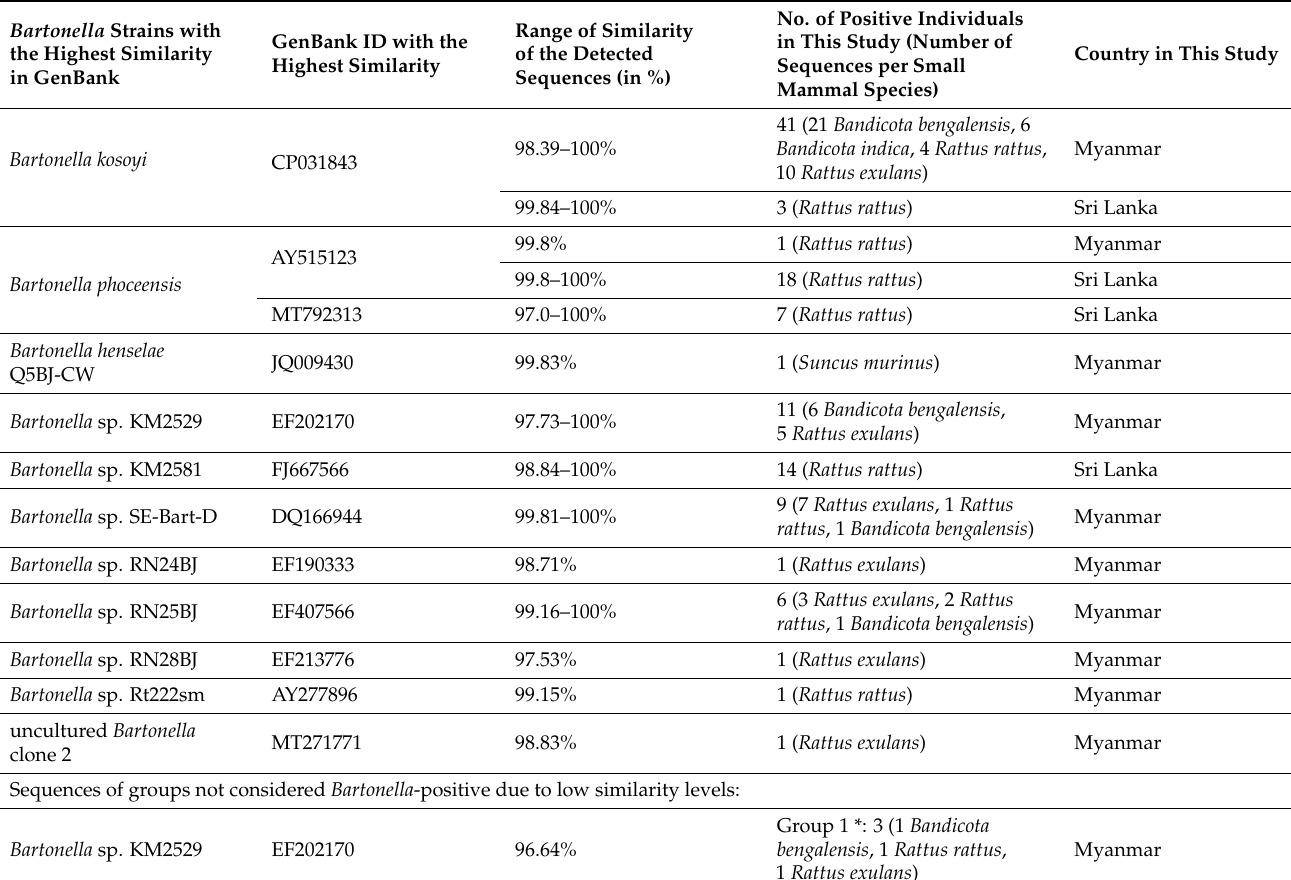
Table 4. Sequencing results of 125 previously selected Bartonella-positive samples from Myanmar and Sri Lanka. Bartonella Strains with the Highest